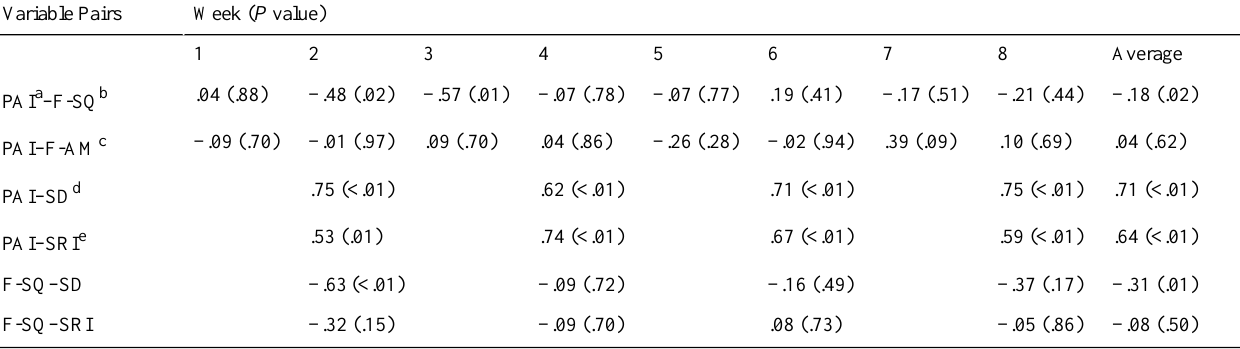
Table 2. Patient-reported outcomes and Fitbit measure statistics. −1.120.1510.4544.9946.50PAI a